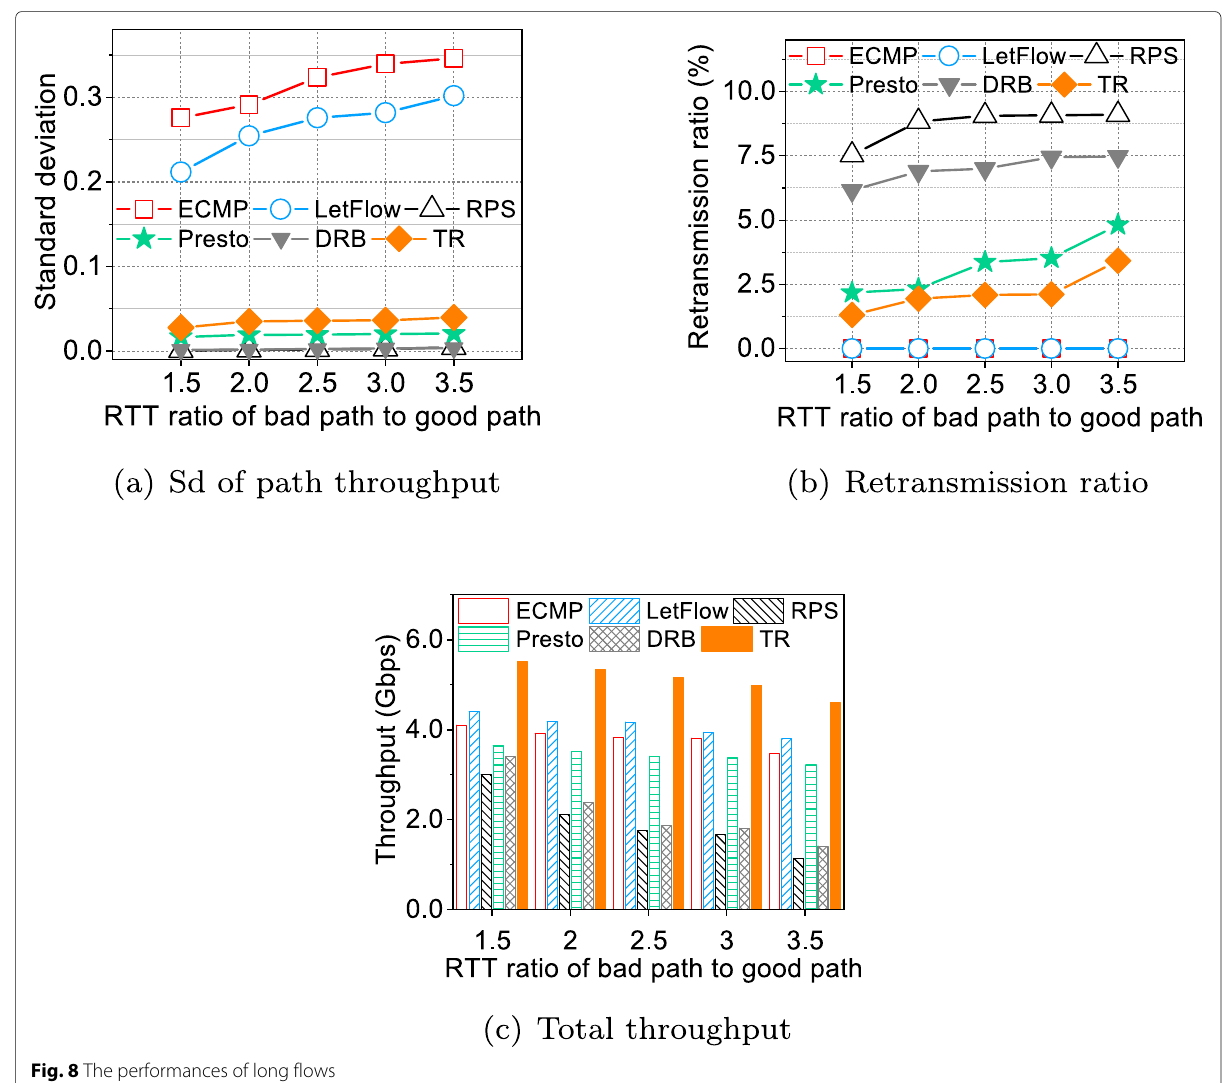
specific proportions of flows belonging to different size ranges in each workload are shown in Table 1. Web Server has the most short flows ( < 100KB) and the fewest long flows ( > 100KB) compared to the other workloads. Meanwhile, the data sizes of long flows in the Web Server workload are all smaller than 1MB.